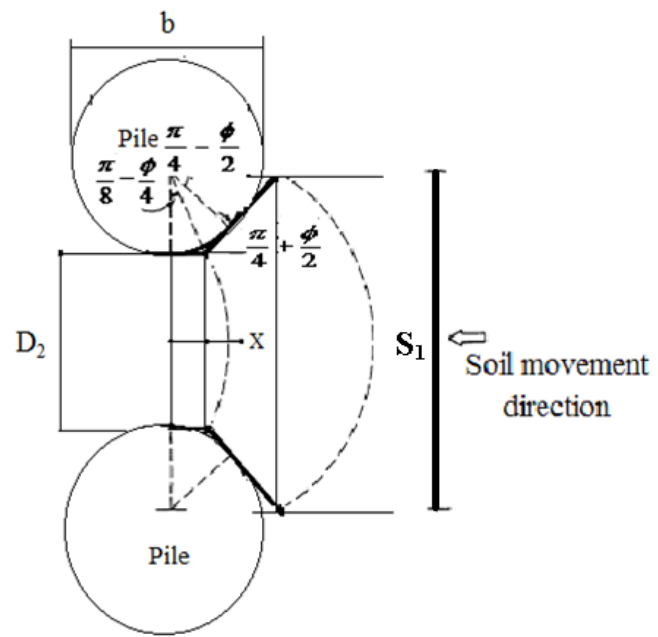
Fig. 1. Plastic deformation of ground around stabilizing piles (Ito et al., 1975)